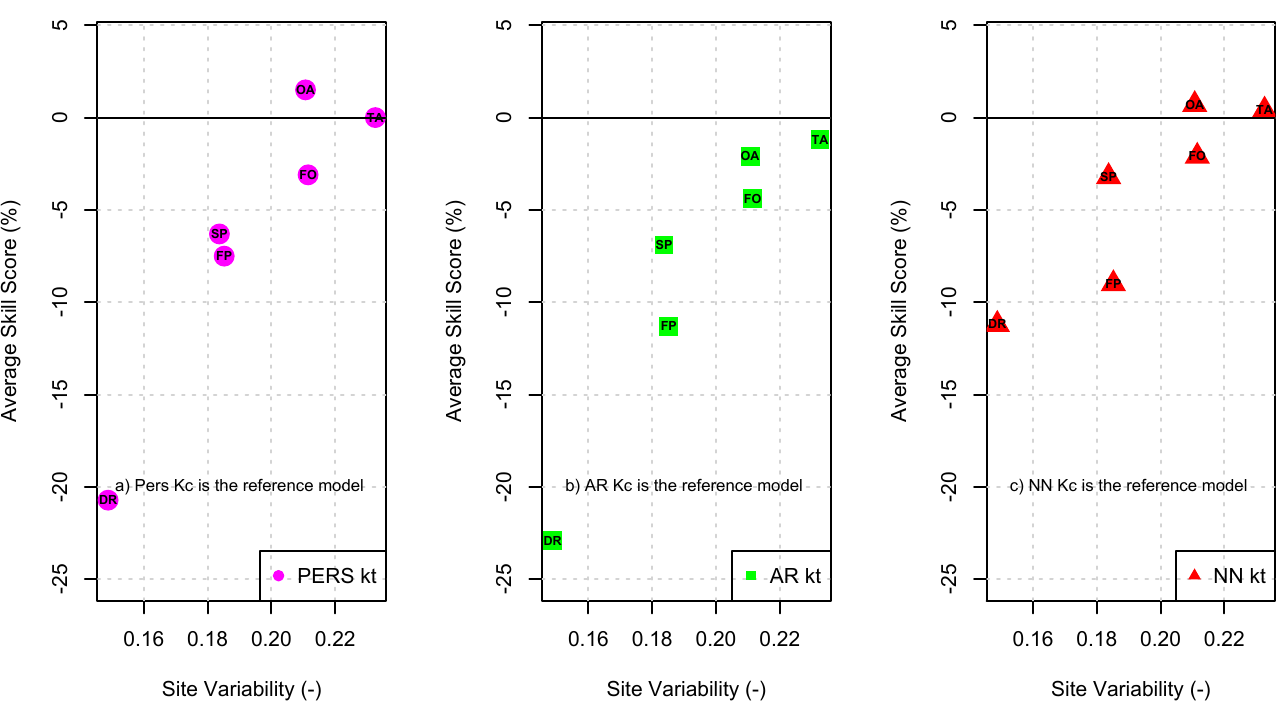
Figure 5. Skill scores of the three forecasting methods based on the clearness index vs. variability of the site. The reference model used to compute the skill score is ( a ) the “Pers kc” model ( b ), the “AR kc” model, and ( c ) the “NN kc” model. Note that the SS are averaged over all six forecast horizons (1 h to 6 h